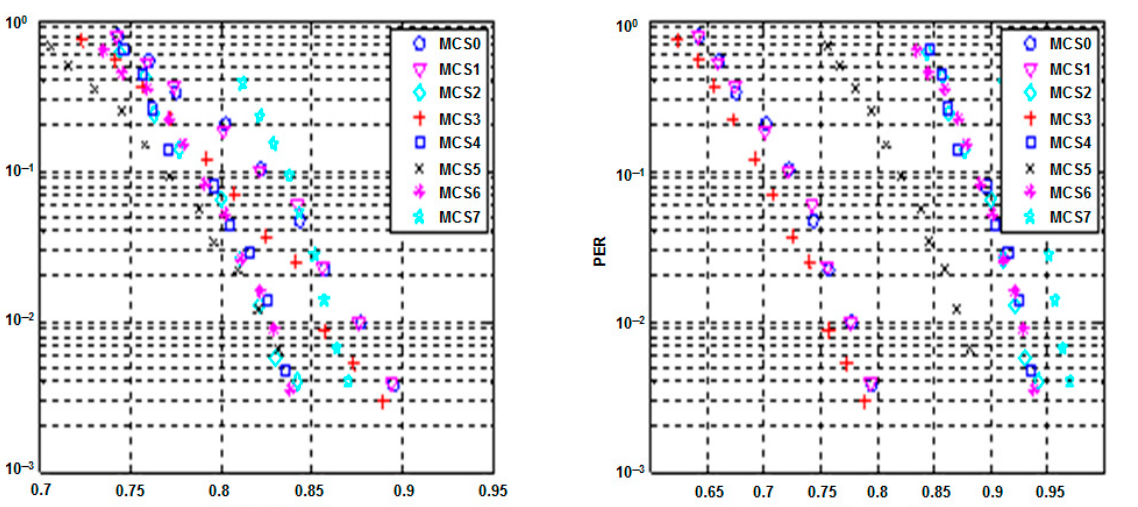
Figure 6. Mean mutual information (MMI)-to- packet error rate (PER) conversion for MCS 0–7.